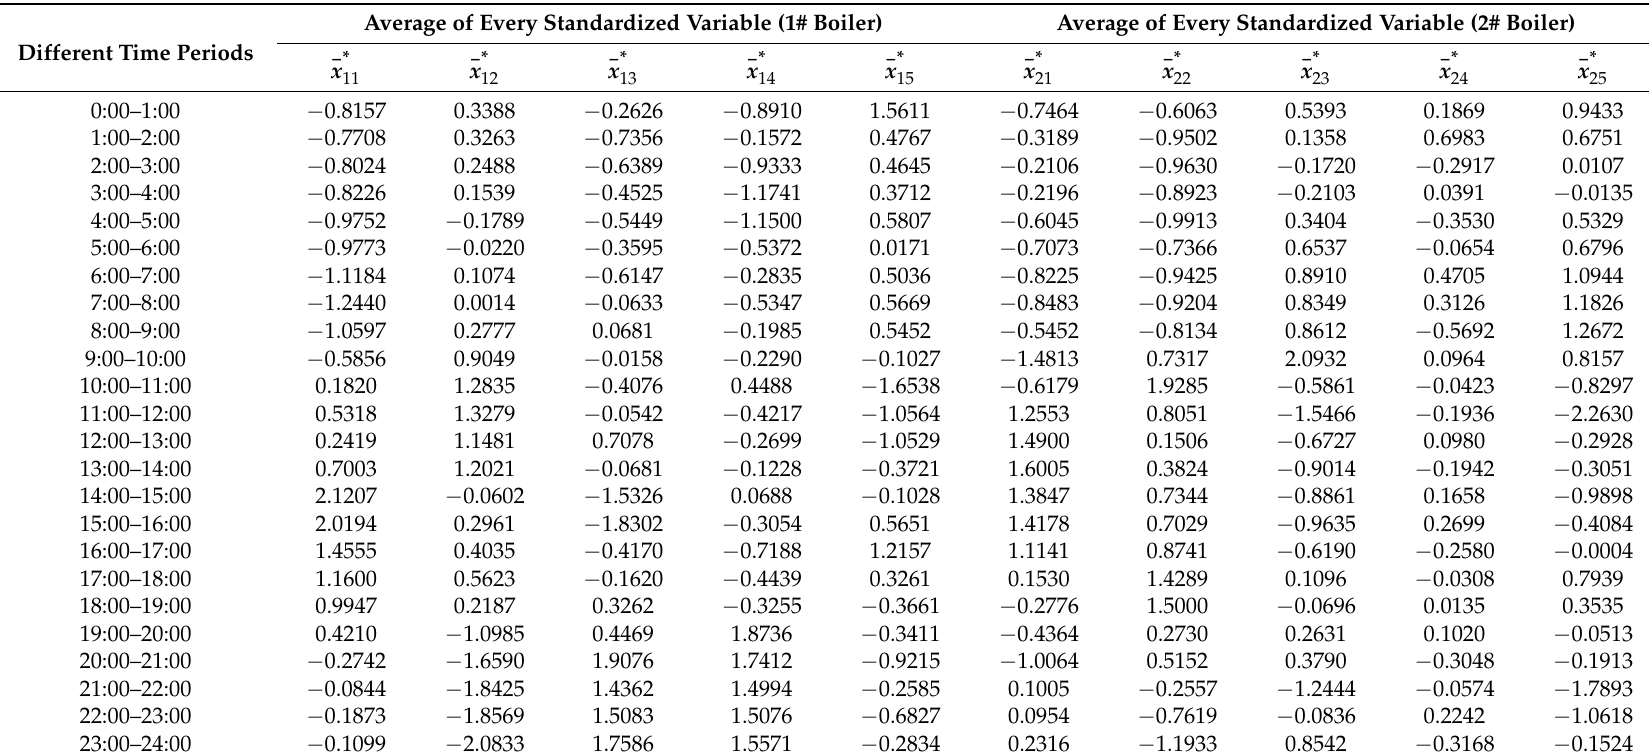
Table 3. The average of every standardized variable of different time periods for 1 day. (1# and 2# boiler combustion control